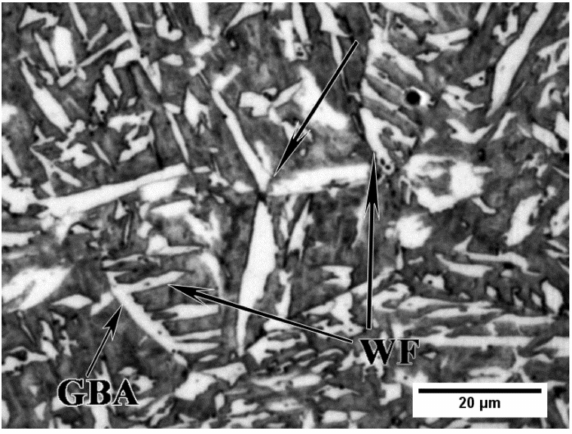
Figure 5. Micrograph of the sample held at 500 ◦ C for 80 s. Light